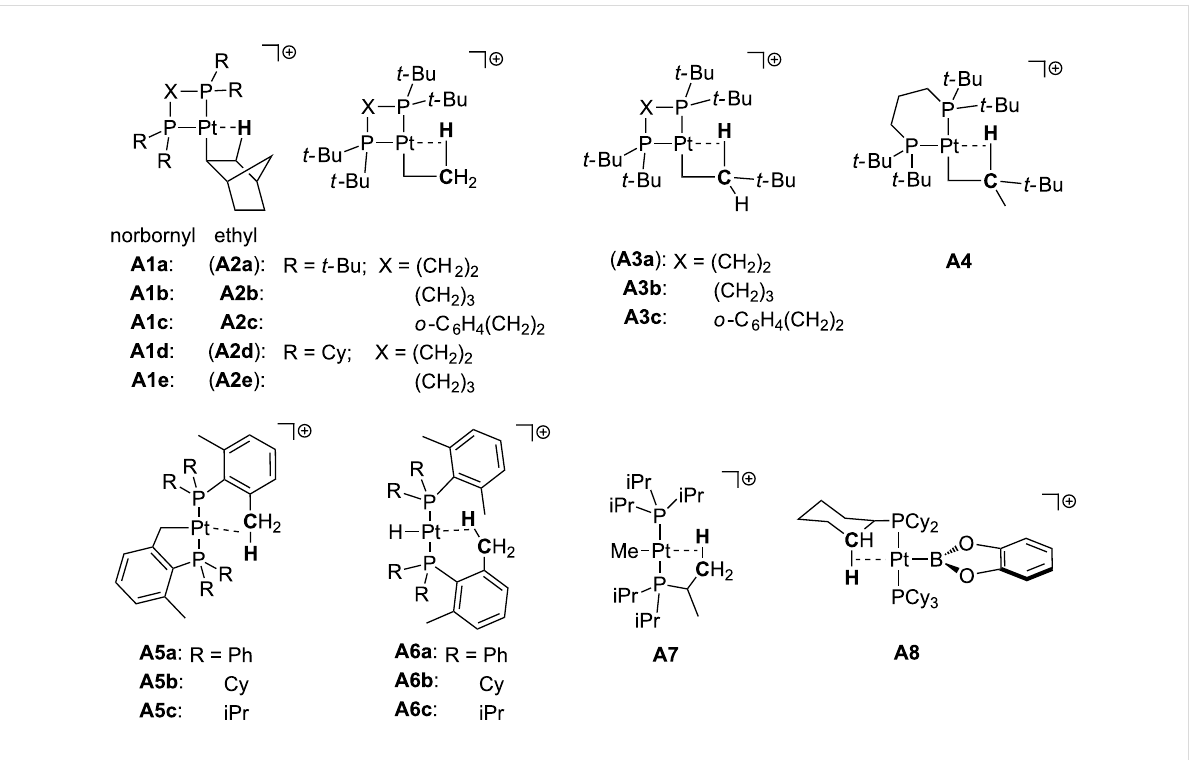
Figure 7: Phosphine-based agostic T-shaped Pt(II) complexes. Compounds in brackets correspond with hydrido–alkene ground